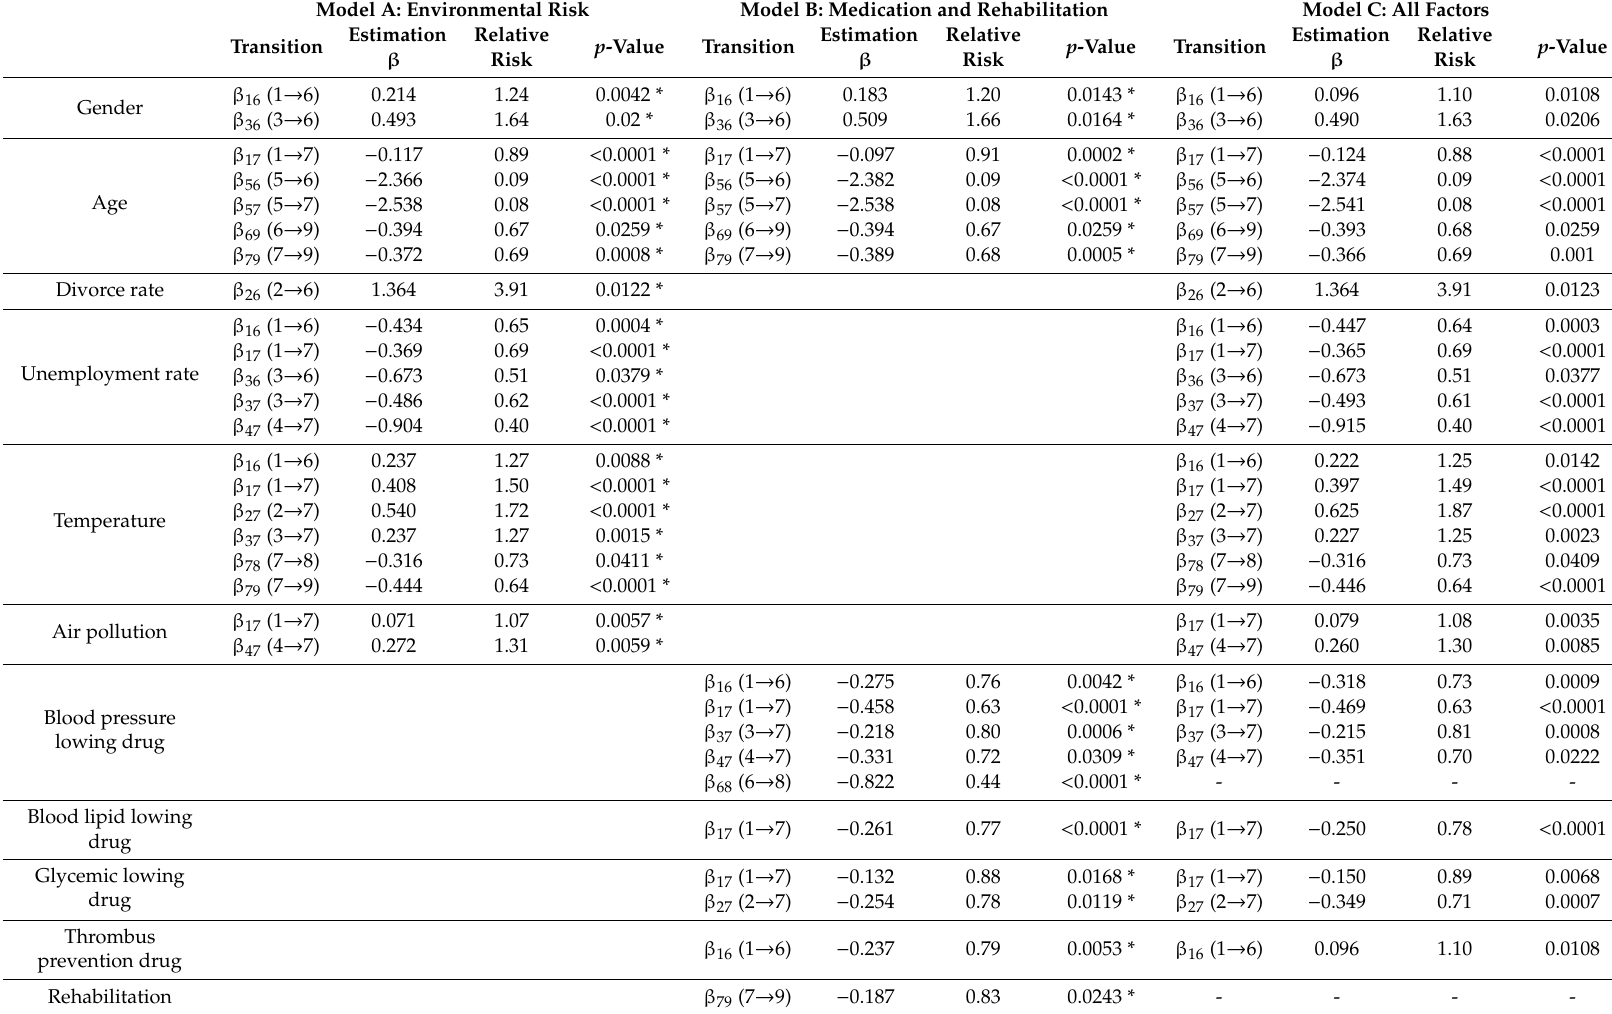
Table 5. The multivariate analysis by di ff erent covariates